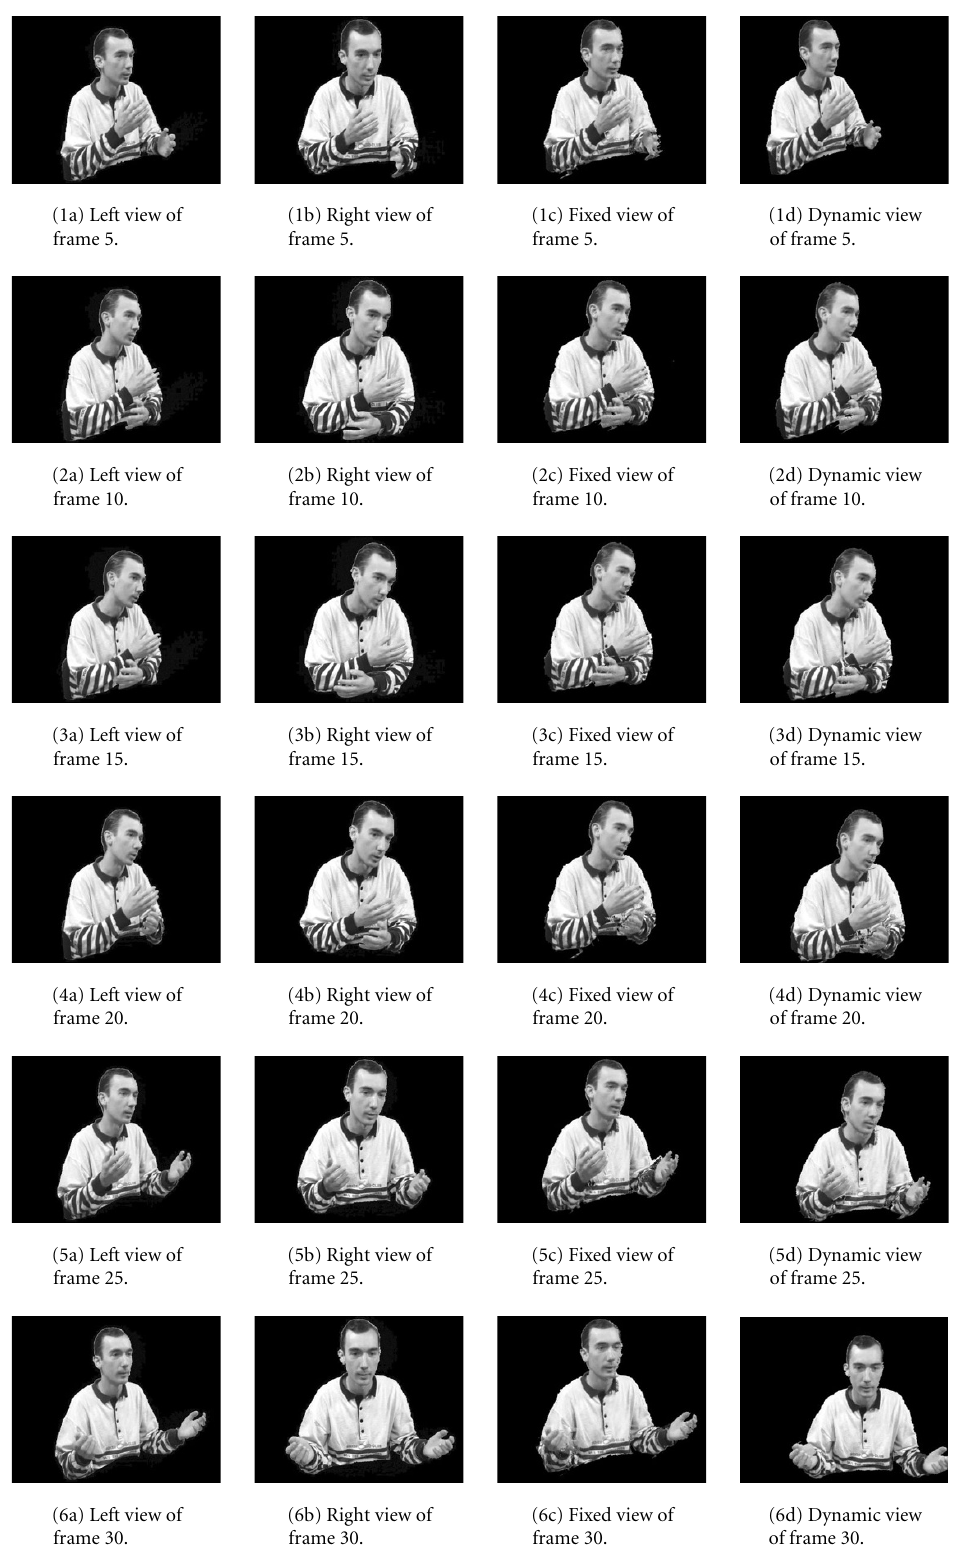
Figure 18: The results of our multi-step algorithm obtained from selected frames (5th, 10th, 15th, 20th, 25th, and 30th) of a pair of stereo sequences (columns 1 and 2) containing 30 frames with viewpoint fixed (column 3) or changed from frame to frame (column